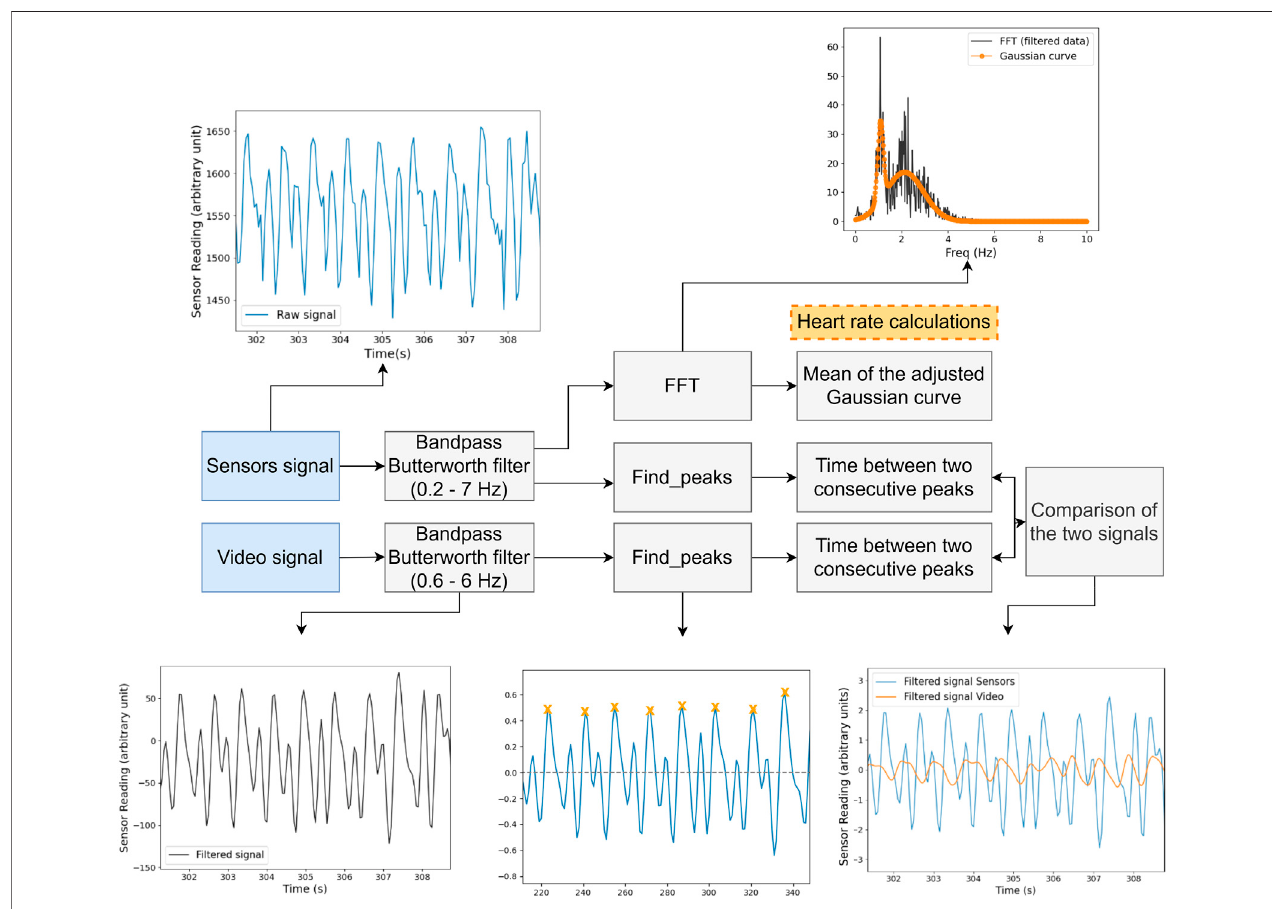
FIGURE 6 | Block diagram of the analysis applied to the acquired signals, both by the sensors and the video.